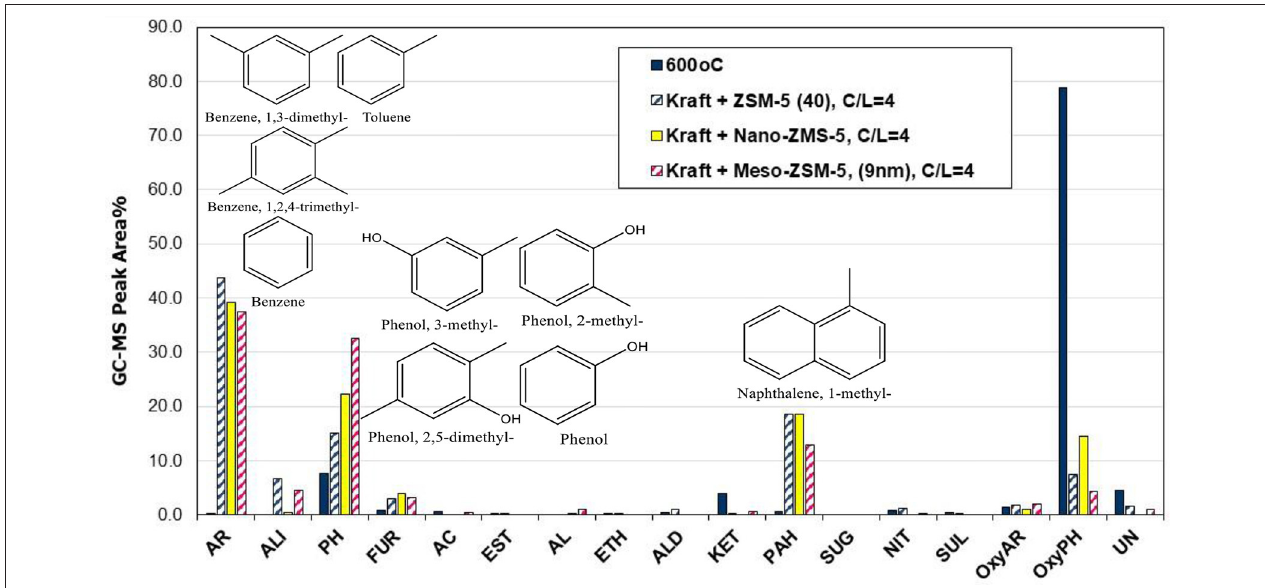
FIGURE 10 | Relative concentration of the various groups of compounds in the bio-oils derived by catalytic fast pyrolysis (CFP) of kraft lignin with conventional microporous, nano-sized and mesoporous ZSM-5 zeolites at 600 ◦ C and at catalyst-to-lignin C/L = 4; indicated compounds in the graph are for the mesoporous ZSM-5